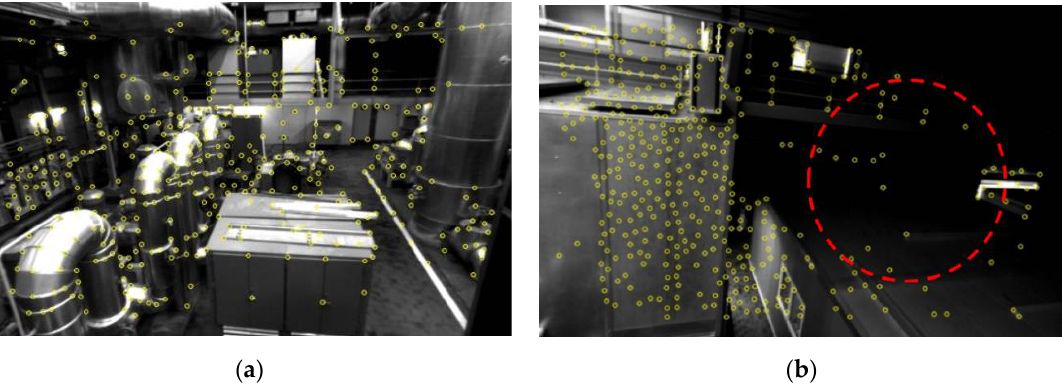
Figure 6. The implementation of the Shi-Tomasi corner detector: ( a ) Detection results in a well-illuminated environment; ( b ) Detection results in a low-illuminated environment.